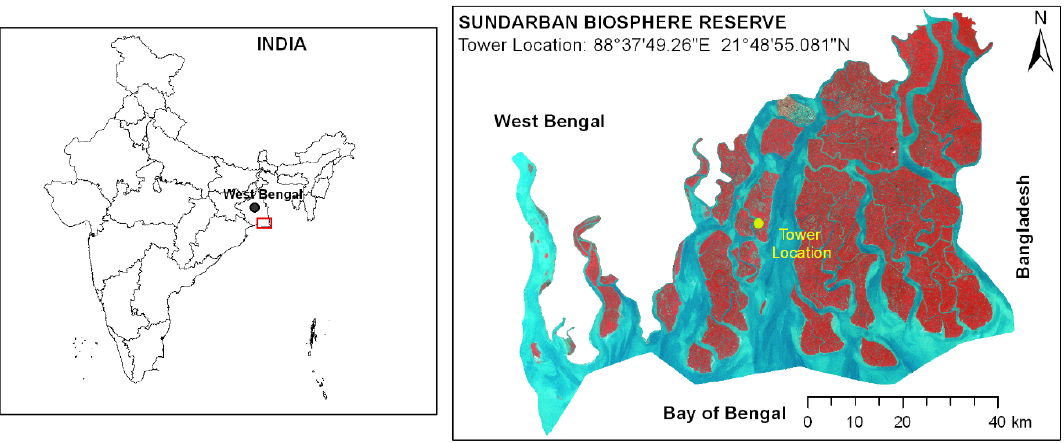
Figure 1. Sundarbans flux tower location on the false color composite (FCC) of IRS AWIFS.